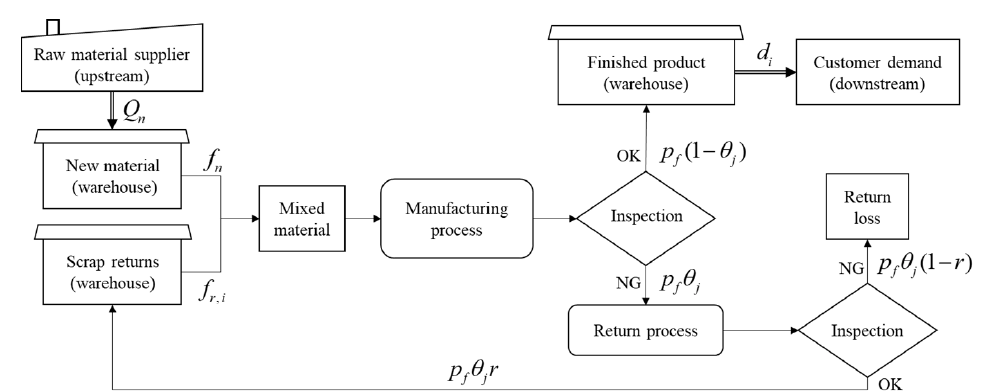
Figure 2. Proposed imperfect production system with scrap recovery activities.